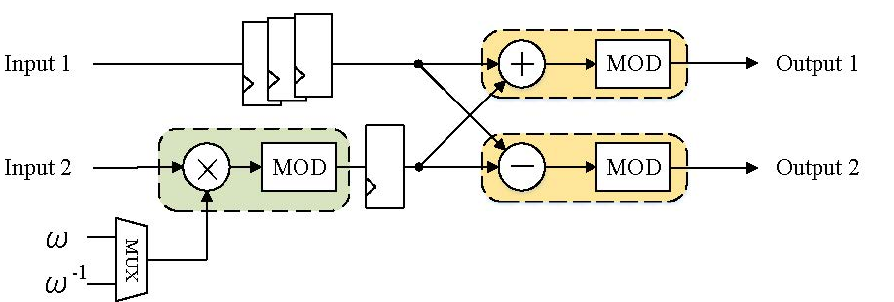
Figure 4. Butterfly unit hardware